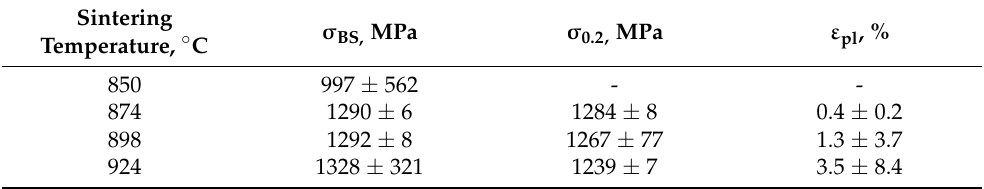
Table 4. Bending properties of samples compacted at 400 MPa and sintered 2 .